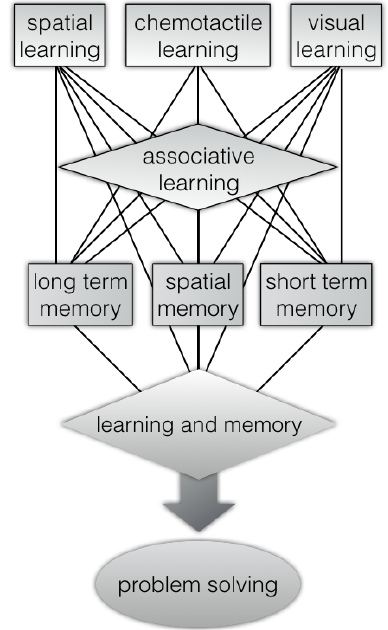
Figure 1. Octopus’s problem-solving abilities [26–32] through learning and memory abilities [19,33– 42] (associative learning [43–45], spatial memory [46–48], visual learning [43,49–51], chemo-tactile learning [52], long-term and short-term memory